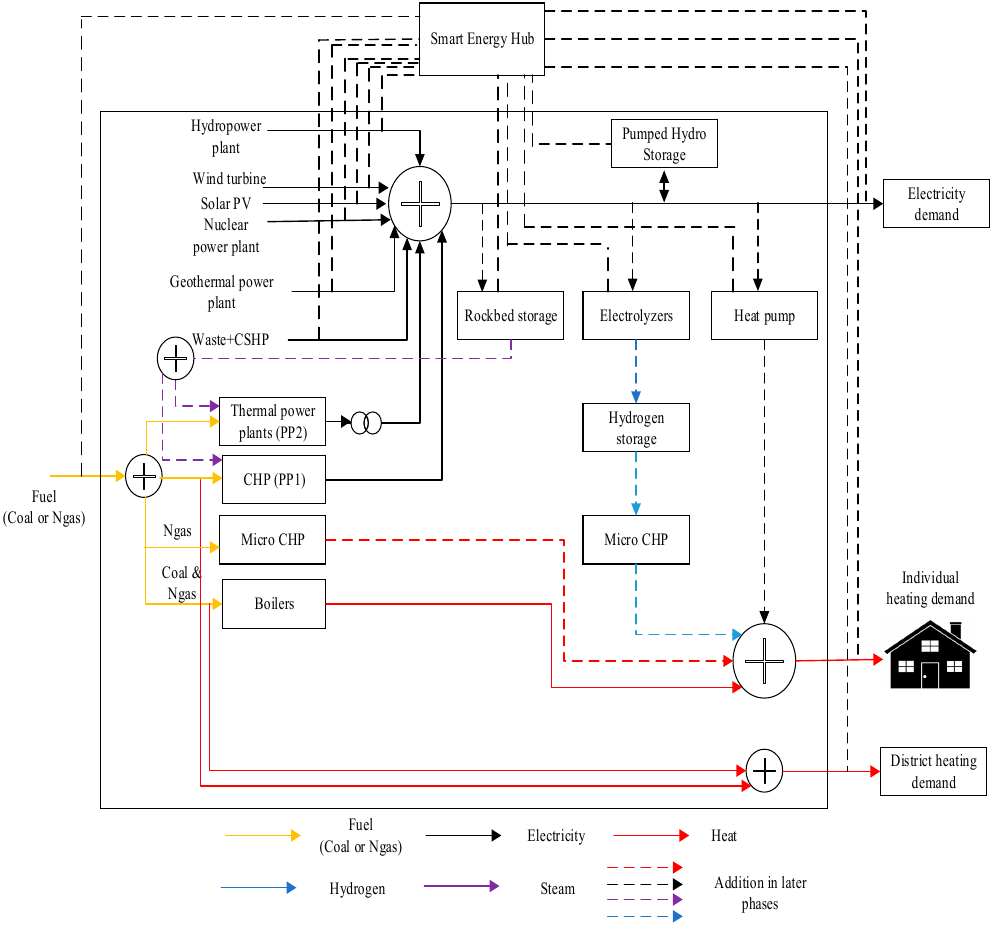
Figure 1. Hybrid energy system modelling using smart energy hub approach for year 2030.